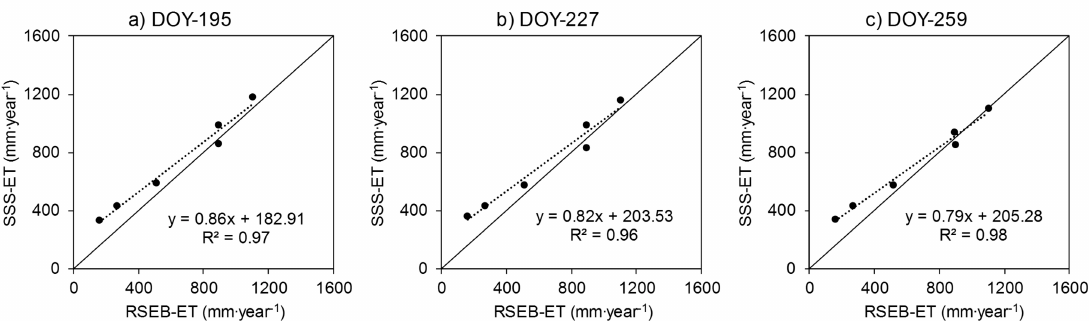
Figure 5. ( a – c ) Comparison of annual SSS-ET and RSEB-ET for six subareas within the CNWR.